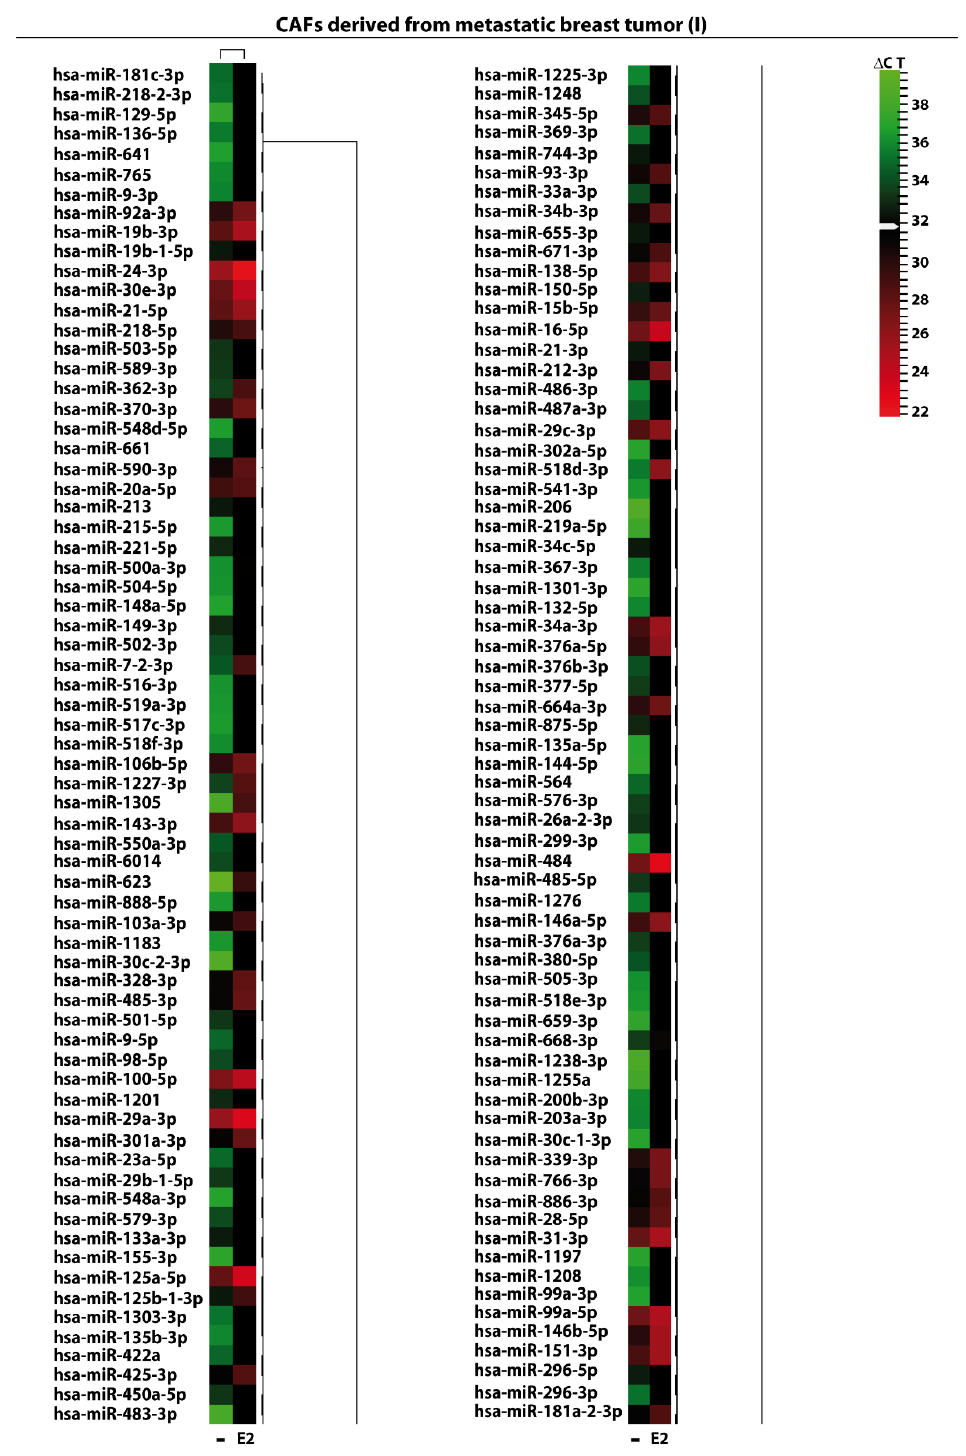
Figure 3. E2-modulated expression of miRNAs in CAFs derived from cutaneous metastatic breast tumor. Heat Map representation of 138 E2-regulated miRNAs in CAFs derived from a cutaneous metastasis treated with 100 nM E2 for 4 h and analyzed by TaqMan Low-Density Array Human miRNA. Rows represent an miRNA and columns represent the treatment exposure. Each column is illustrated according to a colour scale from green (low expression) to red (high expression). The distance measured is Euclidean Distance and the clustering method is complete linkage. Dendrograms of clustering analysis for miRNAs and samples are displayed on the top and right,